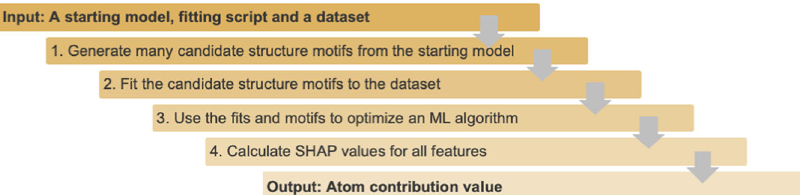
Fig. 2 Pseudo-code describing the four steps of ML-MotEx. A starting model, fi tting script, and dataset are given as input. Firstly, a catalogue of candidate structure motifs is generated (step 1), which are fi tted to the dataset (step 2). The output from step 1 and 2 is then given to an ML algorithm, which learns to predict goodness-of- fi t ( R wp ) values based on the structure motif (step 3). Lastly, SHAP values are calculated for each feature (step 4) which can be converted to atom contribution